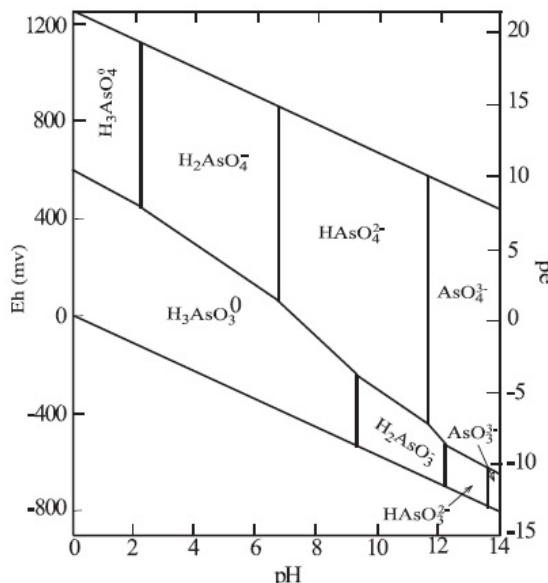
Figure 1. Eh-pH diagram for As-H 2 О system at temperature 25 о С and 1 bar pressure [11, 12].